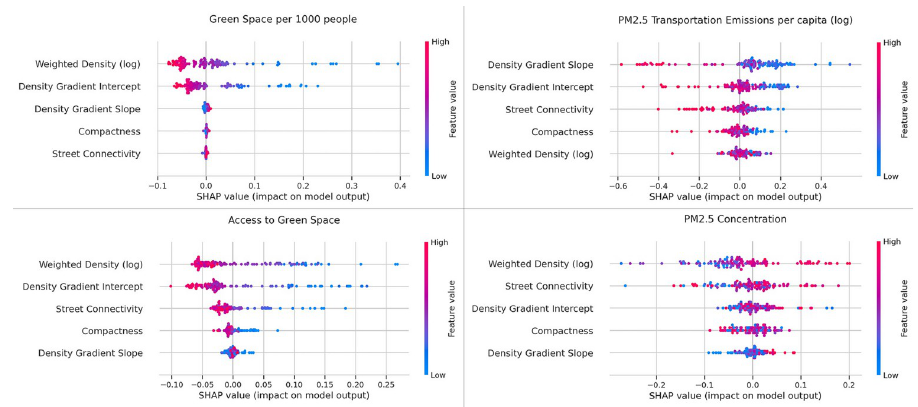
Fig 13. Random forest regression—SHAP values for all environmental outcome